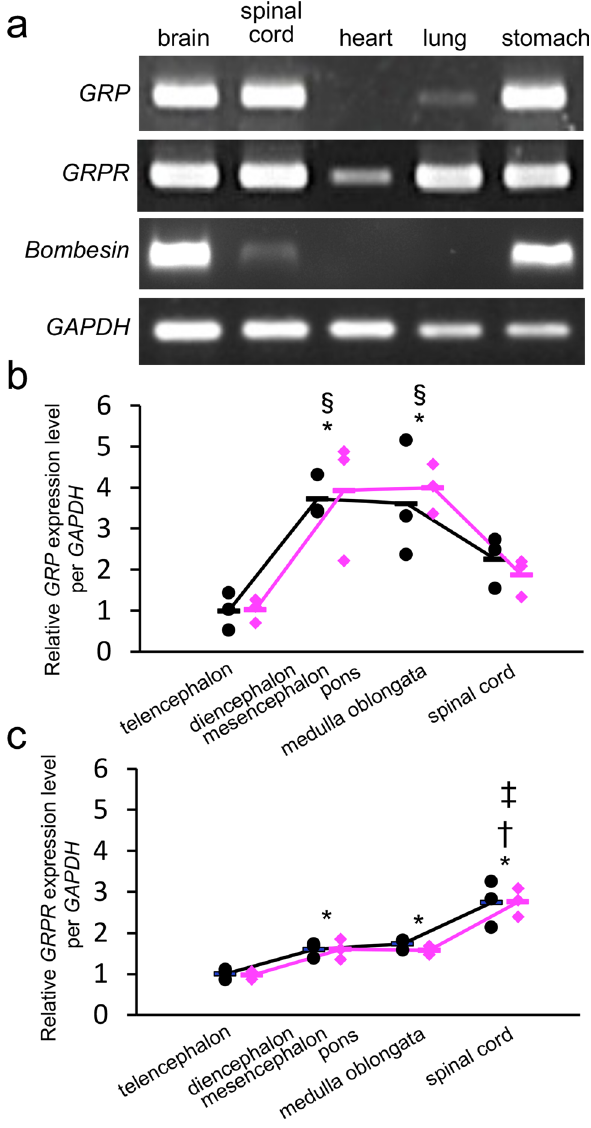
Figure 4. The expression of gastrin-releasing peptide ( GRP ) and GRP receptor ( GRPR ) mRNA in Xenopus tropicalis . ( a ) Reverse transcription (RT)-PCR analysis of GRP and GRPR mRNA expression. Gene expression of GRP (upper panel) and GRPR (middle panel) in the brain, spinal cord, heart, lung and stomach were examine by RT-PCR. Glyceraldehyde-3-phosphate dehydrogenase gene ( GAPDH ) was used as the internal control (bottom panel). Cropped gel images of electrophoresis are shown. Original images are shown in Supplementary Fig. S4. ( b , c ) The expression levels of GRP and GRPR mRNA in Xenopus central nervous system measured by the real-time quantitative PCR. Relative expression levels of GRP ( b ) and GRPR ( c ) in the telencephalon, the diencephalon/mesencephalon/pons/cerebellum, the medulla oblongata, and the spinal cord of males and females were analyzed. P values indicate statistical tests using linear mixed model with Bonferroni correction for multiple comparisons ( vs. telencephalon, * P < 0.01; vs. diencephalon/mesencephalon/pons/cerebellum, † P < 0.01; vs. medulla oblongata, ‡ P < 0.01; vs. spinal cord, § P < 0.05). No sex differences and no interactions between sex and tissue were detected. Dots and bars indicate values of each sample and means of the samples, respectively. Black: males, magenta: